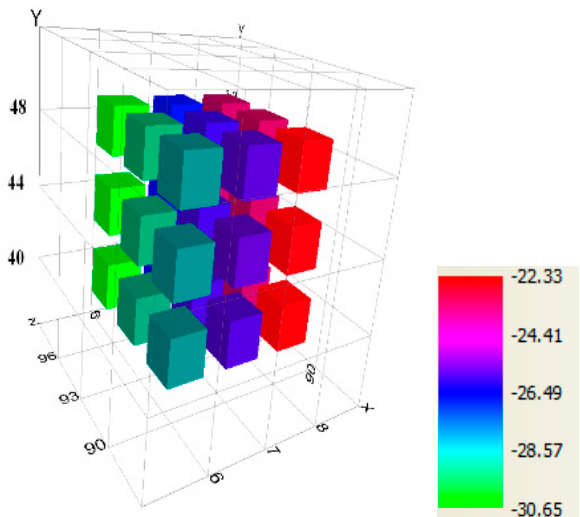
Figure 10. Effects of P m , N bat, and SOC H on battery SOC. Figure 10. E ff ects of P m , N bat, and SOC H on battery